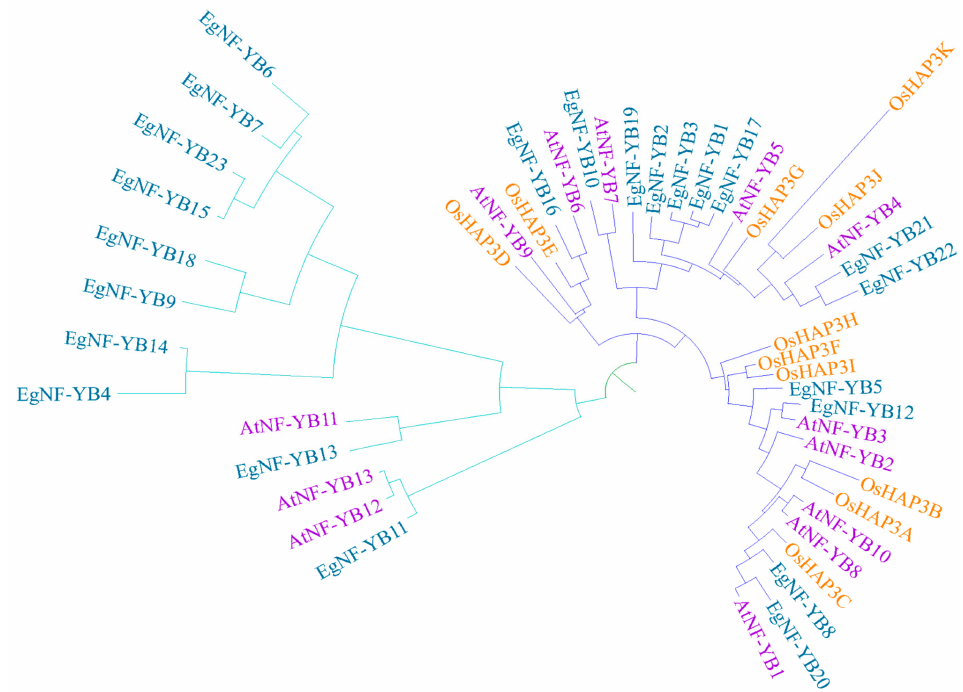
Figure 1. Phylogenetic classification of NF-YB genes in Eucalyptus grandis , Arabidopsis and Oryza sativa